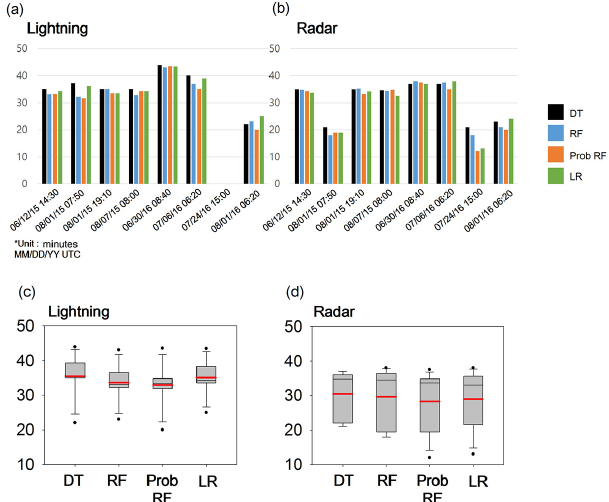
Figure 8. Averaged lead time based on lightning and radar CAPPI data for the deterministic DT and RF, probabilistic RF, and LR mod- els. Box plot of lead time based on lightning and radar CAPPI data for the (c) lead time based on lightning data and (d) lead time based on radar CAPPI data. While red lines represent in the boxes mean value, grey lines represent median